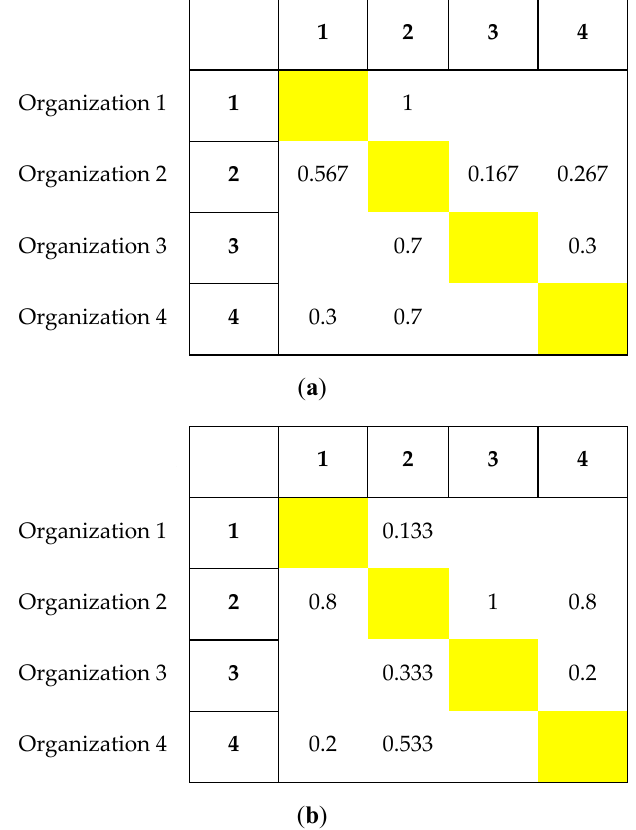
Figure 6. Numerical Design Structure Matrices (NDSMs) of downstream sensitivity ( a ) and probability of change ( b ).